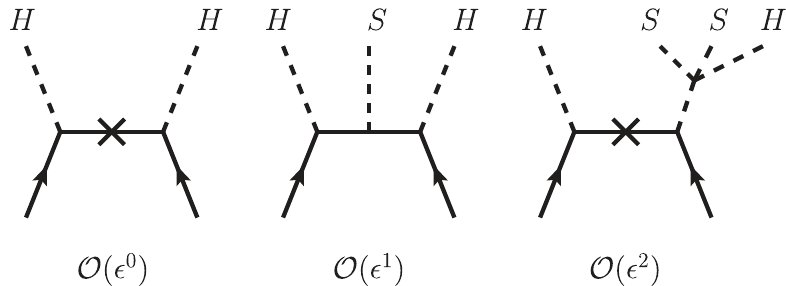
Figure 7 . Feynman diagrams for neutrino mass generation through seesaw mechanism under the Z 4 (cid:13)avor